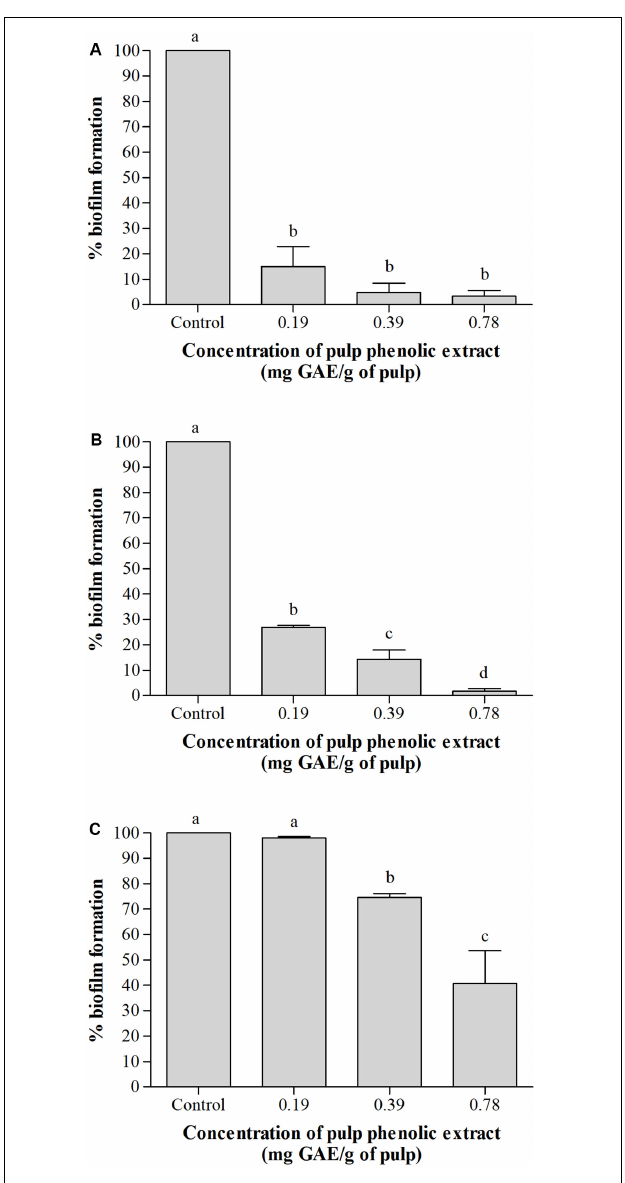
FIGURE 2 | Percentage (%) of biofilm formation by A. hydrophila (A) , E. coli (B) , and S. marcescens (C) in absence and presence of pulp phenolic extract of S. cumini (L.) Skeels at sub-MIC of 0.19, 0.39, and 0.78 mg GAE/g of pulp. Means followed by different letters differ statistically ( p < 0.05).